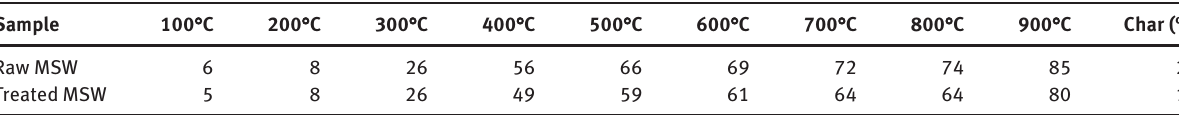
Table 2 Percentage weight loss of treated and raw MSW.